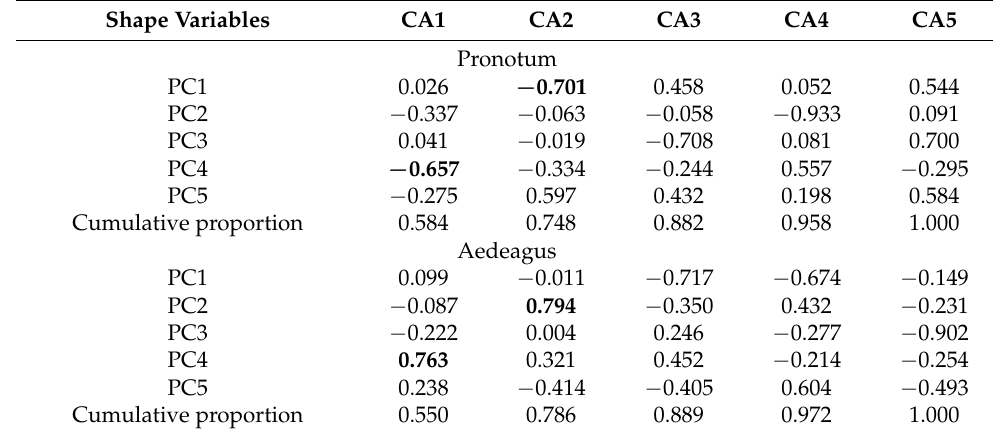
Table 4. The structure matrix of shape variables (principal component scores—PC) of canonical discriminant analysis explained by canonical axes